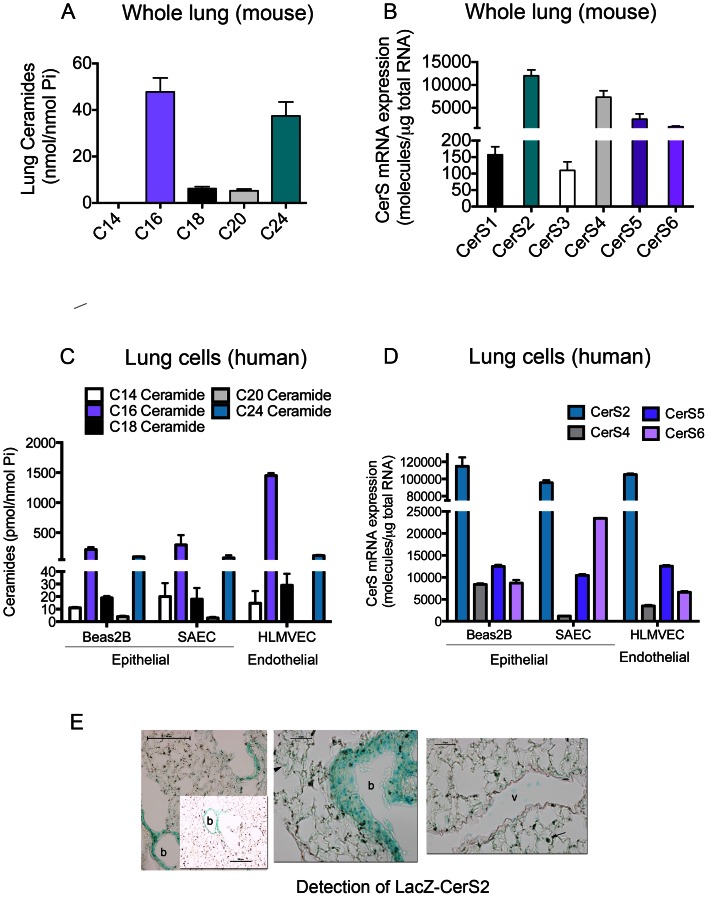
Ceramide levels and CerS expression in the normal lung and human lung cells.A, Levels of ceramide species in the whole mouse lung measured by LC-MS/MS (C57BL/6 mice; female; age 3 months; mean+SEM; n = 5). B, Levels of individual CerS mRNA expressed in the whole mouse lung, measured by real time q-rtPCR; mean+SD, n = 5. C–D, Levels of ceramide species (C) and of CerS mRNA (D) in lung structural cells grown in culture: human bronchial epithelial cell line Beas2B, primary human small airway epithelial cells (SAEC), and primary human microvascular endothelial cells (HLMVEC); means+S.E.M., n = 3. Bar colors of ceramide species corresponding to the color of CerS responsible for its synthesis. E, X-Gal staining (blue) of frozen lung sections from CerS2−/+ mice at various magnifications (size bar 100 µm in the left panels and 25 µm in the middle and right panels). Note more prominent transcriptional activity of the LacZ-promoter (blue) in the epithelial layers of the bronchi (b), rather than in the vascular (v) endothelium or alveoli (the arrow indicates an alveolar macrophage).